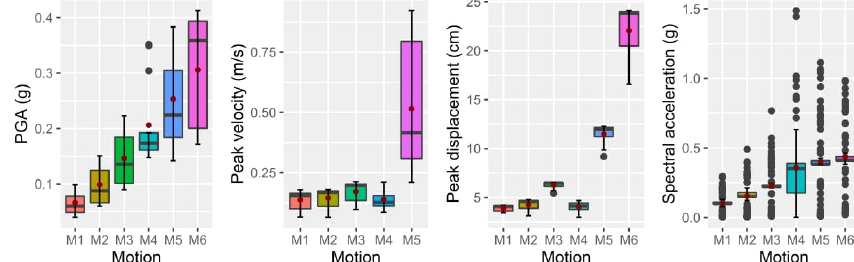
Figure 13. Box and whisker plot for ground motion parameters of the soil profile at P1 CST football ground in Zone II.